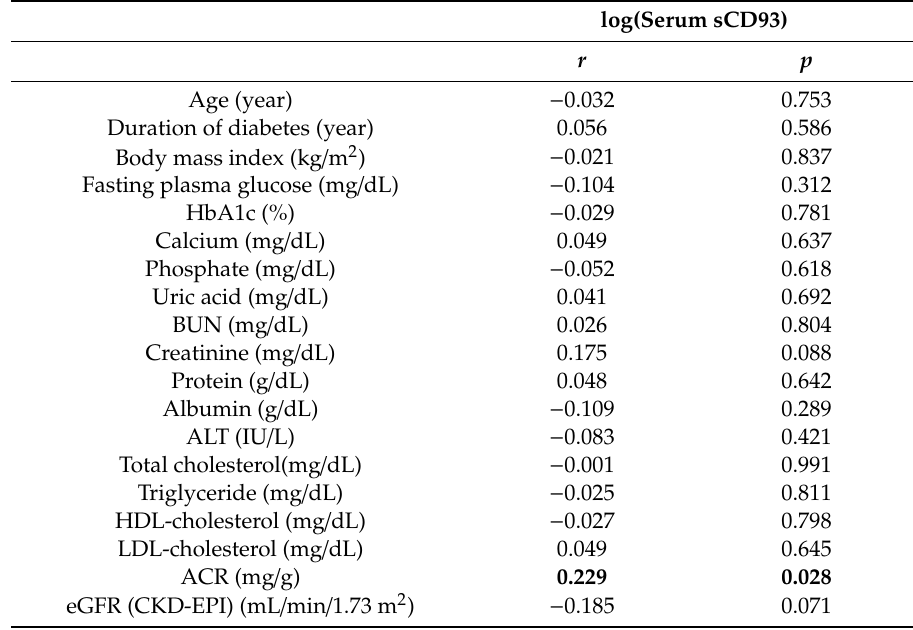
Table 3. Correlations between serum sCD93 and various clinical parameters.